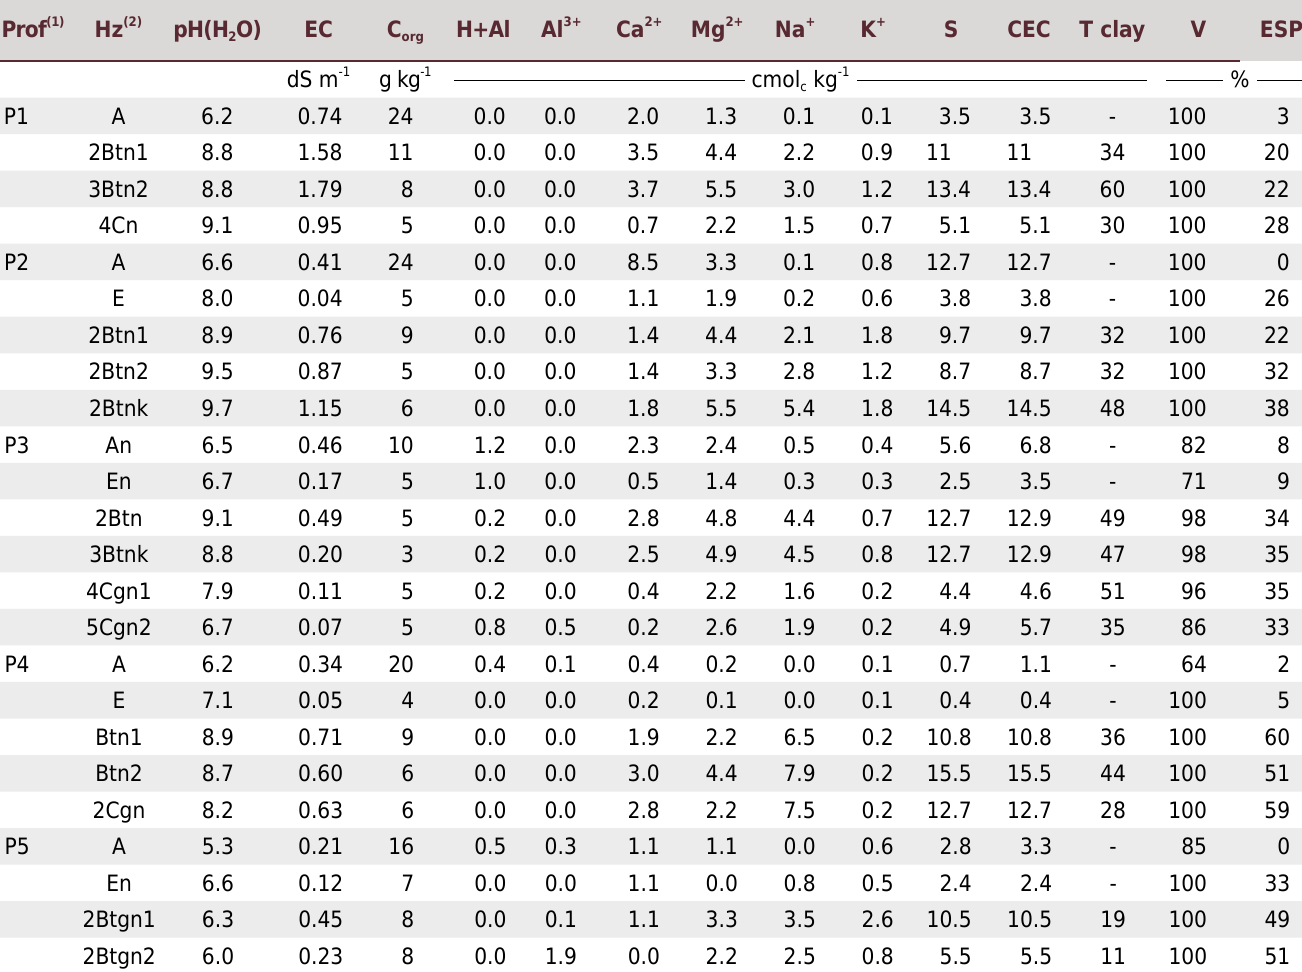
Table 3. Chemical analysis of the profiles